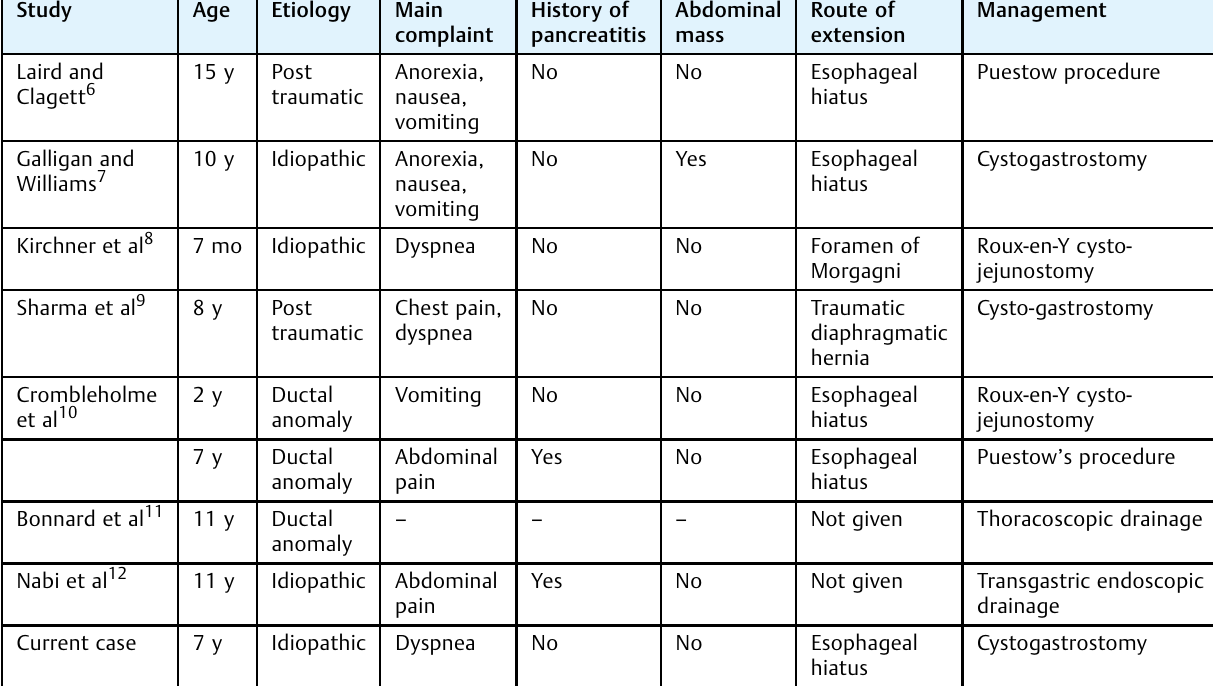
Table 1 Cases of MPP in children reported in